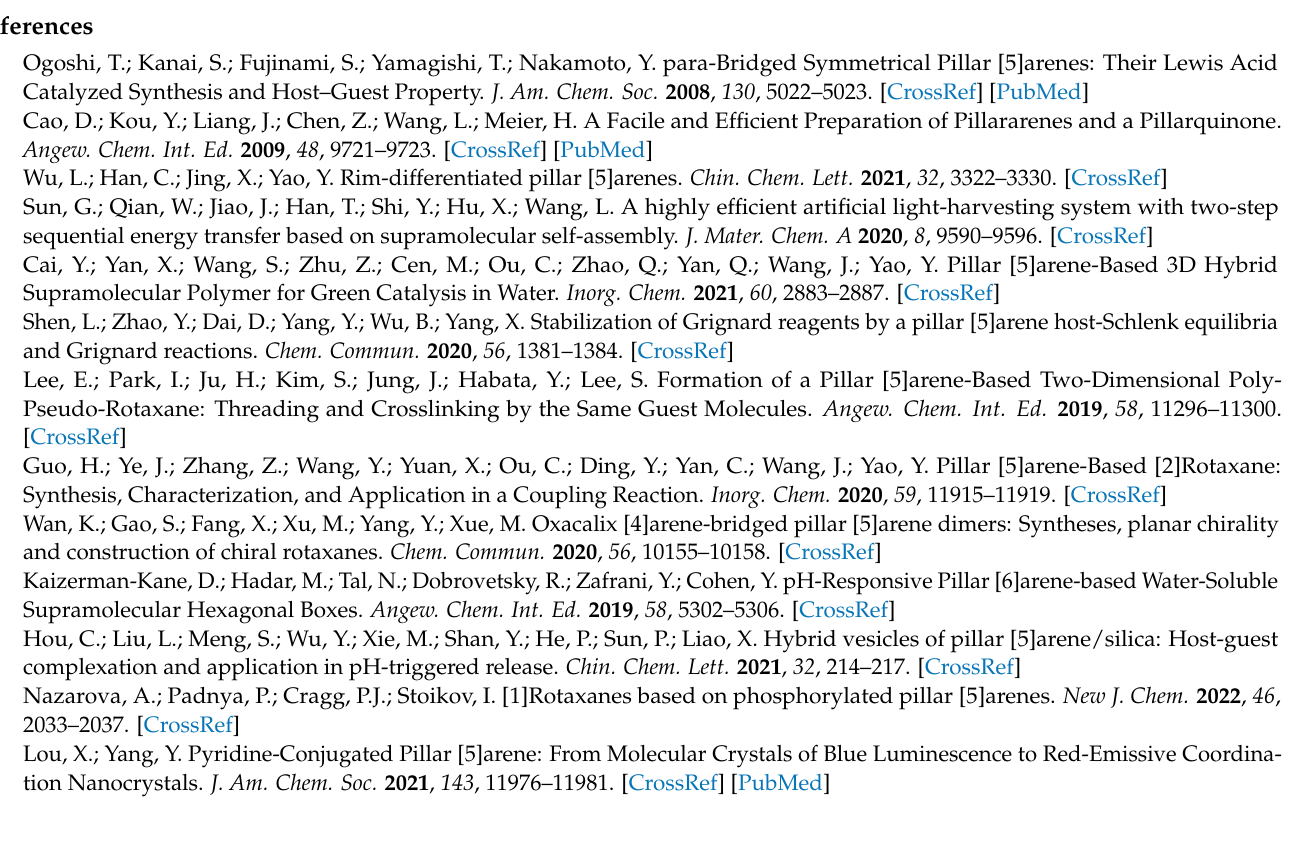
Table S1: Information of crystal data for TP5; Figure S4: Fluorescence spectra of TP5 and TP5 /Zn; Figure S5: Partial 1 H NMR (CDCl 3 , 400 MHz, R.T.) of PM1 , PM1 + TP5 /Zn and TP5 /Zn; Figure S6: UV-Vis spectra of TP5 /Zn and PM1 with different ratio; Figure S7: UV-Vis absorption spectra (H 2 O, RT) of different concentrations of Dox; Figure S8: Drug release curves of TP5 /Zn/ PM -based particles in PBS solutions of different pH values at 37 ◦ C. BrP5 and terpyridine are prepared according references. References [41,42] are cited in the supplementary